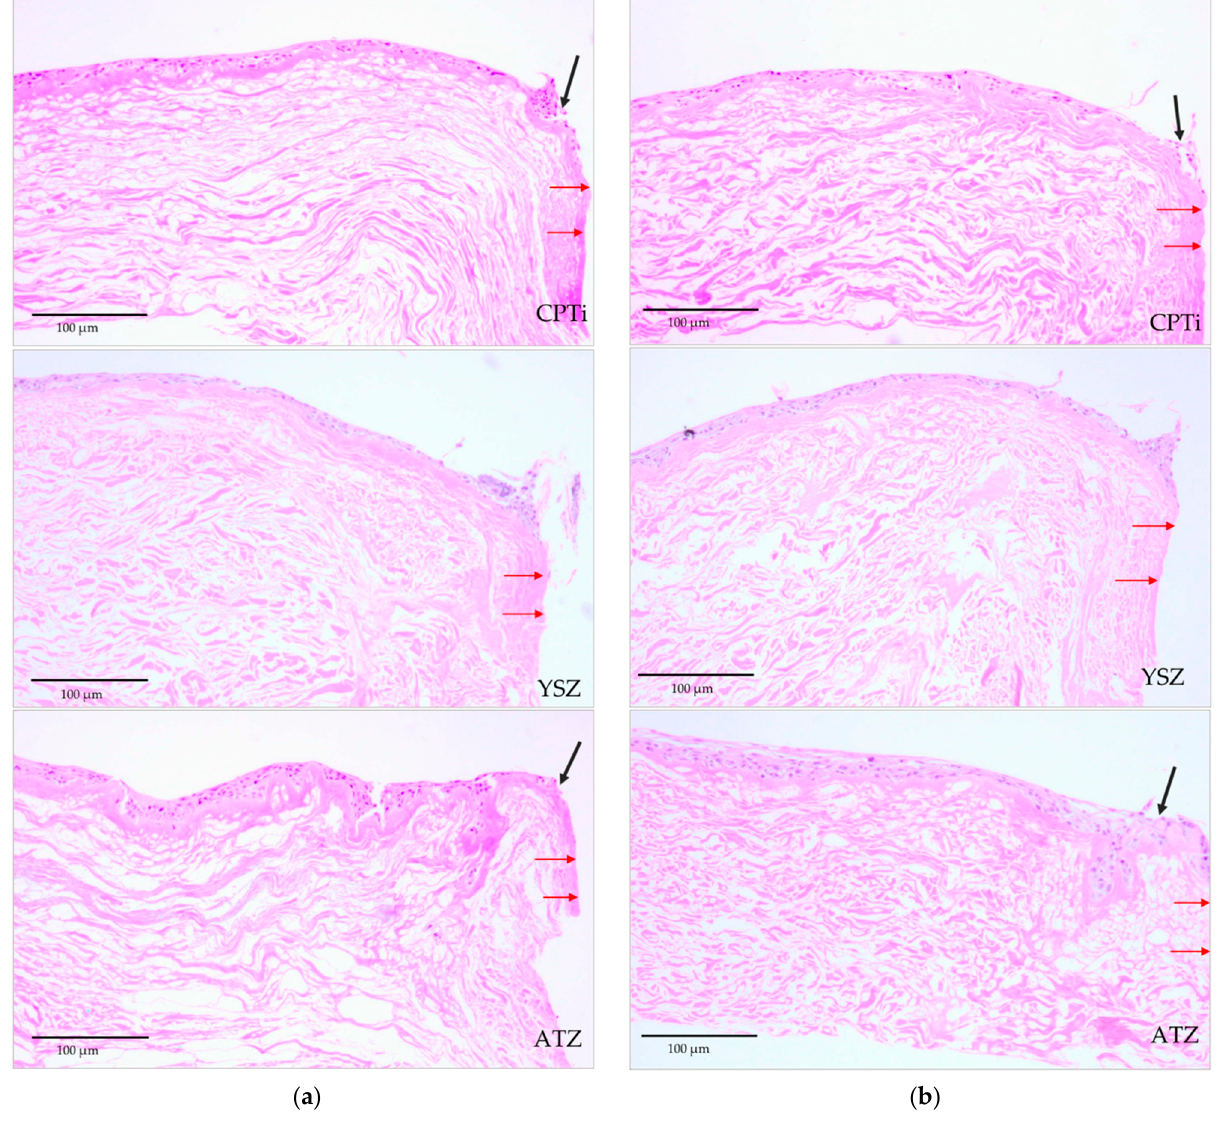
Figure 6. Tissue model following detachment of the disk (10× magnification); ( a ) UV-treated specimen–soft tissue interface and ( b ) nontreated specimen–soft tissue interface showing a few layers of epithelial cell formed and distortion of cell layers at the soft tissue–disk interface (shown in black arrows) for each type of materials. The soft tissue–specimen interface is indicated by red arrows.